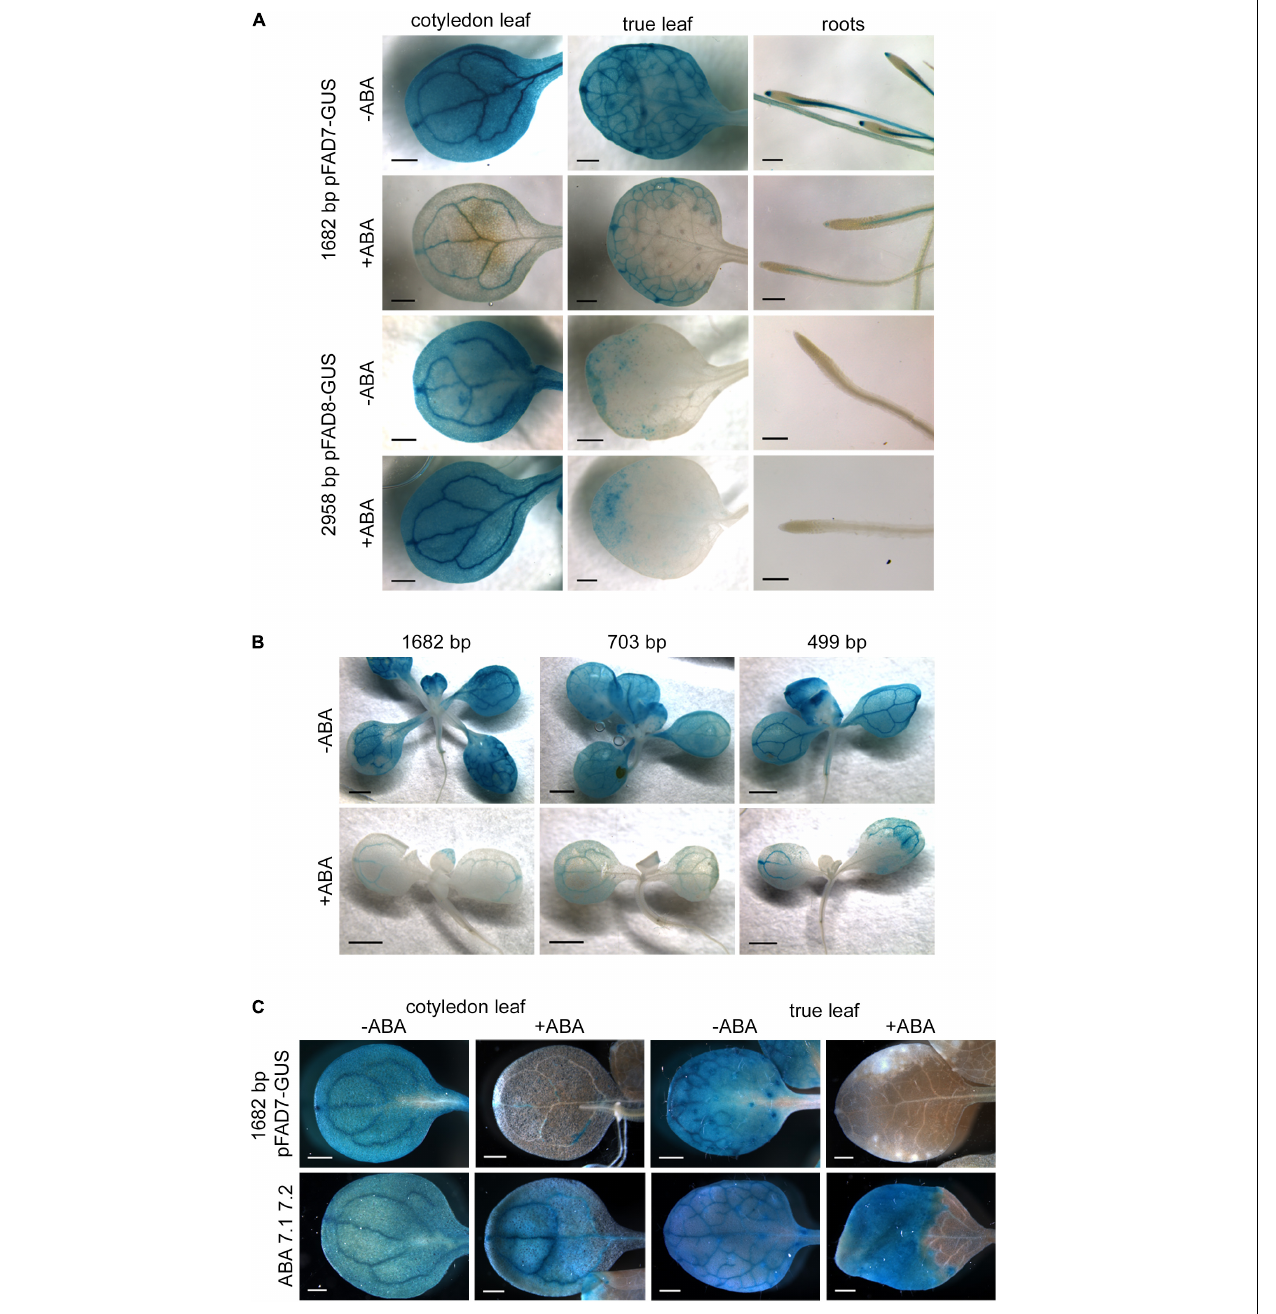
FIGURE 5 | Effect of ABA on the activity of AtFAD7 and AtFAD8 promoters. (A) Histochemical GUS assay in 2-week old cotyledons, true leaves and roots from transgenic lines carrying the 1,682 bp AtFAD7 and 2,958 bp AtFAD8 gene promoter fragments. Two week-old plants were treated for 48 h with 100 µ M ABA (+ ABA) and then subjected to 1 or 3 h of GUS incubation in the case of the 1,682 bp AtFAD7 or the 2,958 bp AtFAD8 gene promoter, respectively. Untreated (-ABA) plants were used as a control. Images are representative of at least three independent transgenic lines. Scale bars represent: 500 µ m in leaves and 200 µ m in roots. (B) Histochemical GUS assay in AtFAD7 deleted promoter:GUS stable Arabidopsis lines after 48 h of 100 µ M ABA treatment. Two week-old plants carrying the 1,682 bp control fragment and the 703 and 499 bp deleted fragments were used for the analysis. (+ ABA), plants treated with 100 µ M ABA; (-ABA), control untreated plants. Images are representative of at least three independent transgenic lines. Scale bars represent 1,000 µ m. (C) Histochemical GUS assay in transgenic lines in which the two ABA repression sequences detected in the AtFAD7 1,682 bp gene promoter were modified by site-directed mutagenesis (ABA 7.1 7.2). Two week-old plants were treated for 48 h with 100 µ M ABA (+ ABA) and then subjected to 1 h of GUS incubation. The unmodified 1,682 bp AtFAD7 gene promoter fragment was used as a control. (+ ABA), plants treated with 100 µ M ABA; (-ABA), control untreated plants. Images are representative of at least three independent transgenic lines. Scale bars represent 500 µ